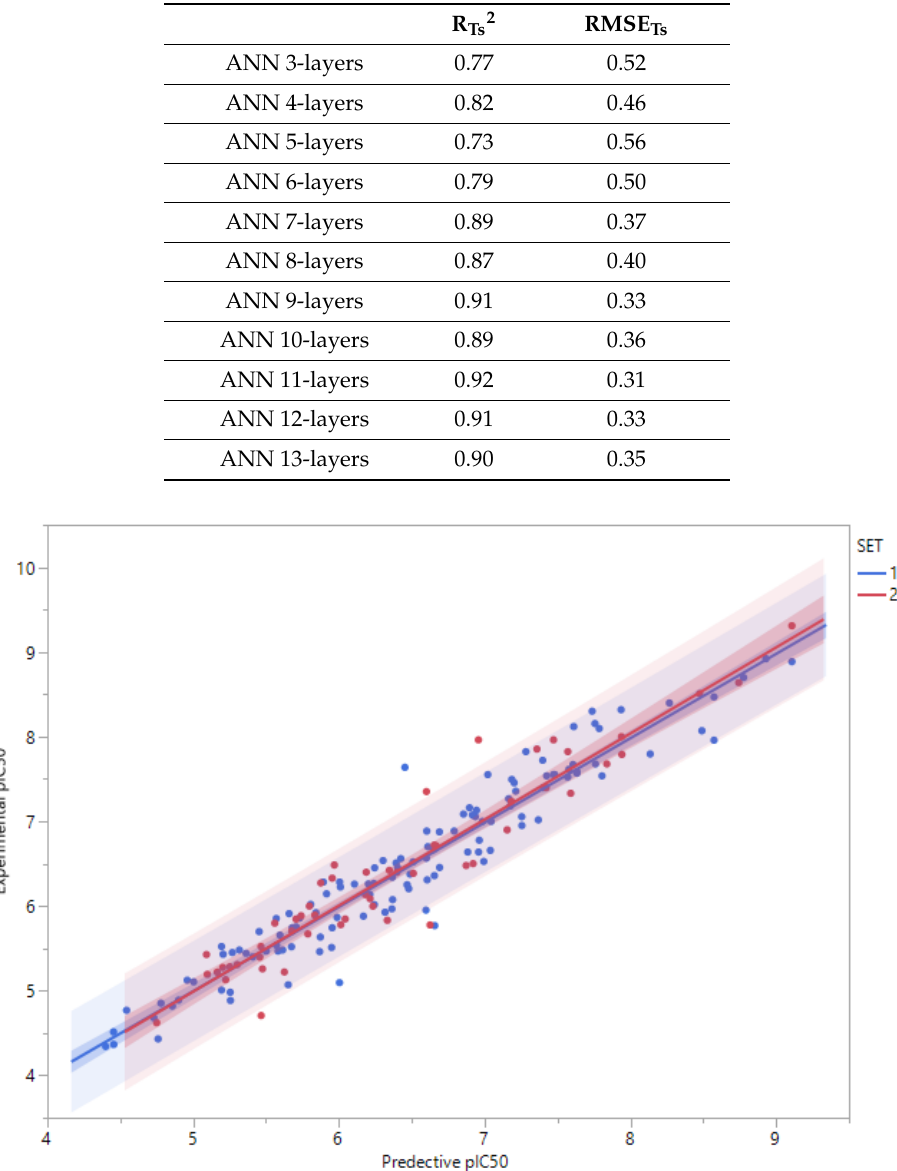
Table 4. Test-set values by using ANN approach.